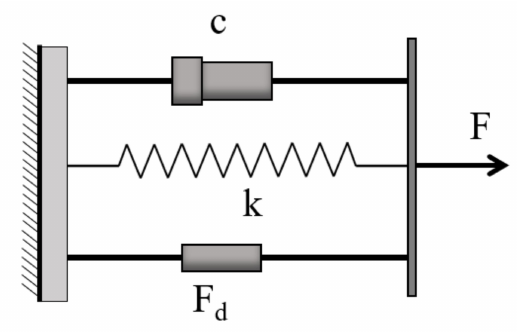
Figure 11. The combined damping model